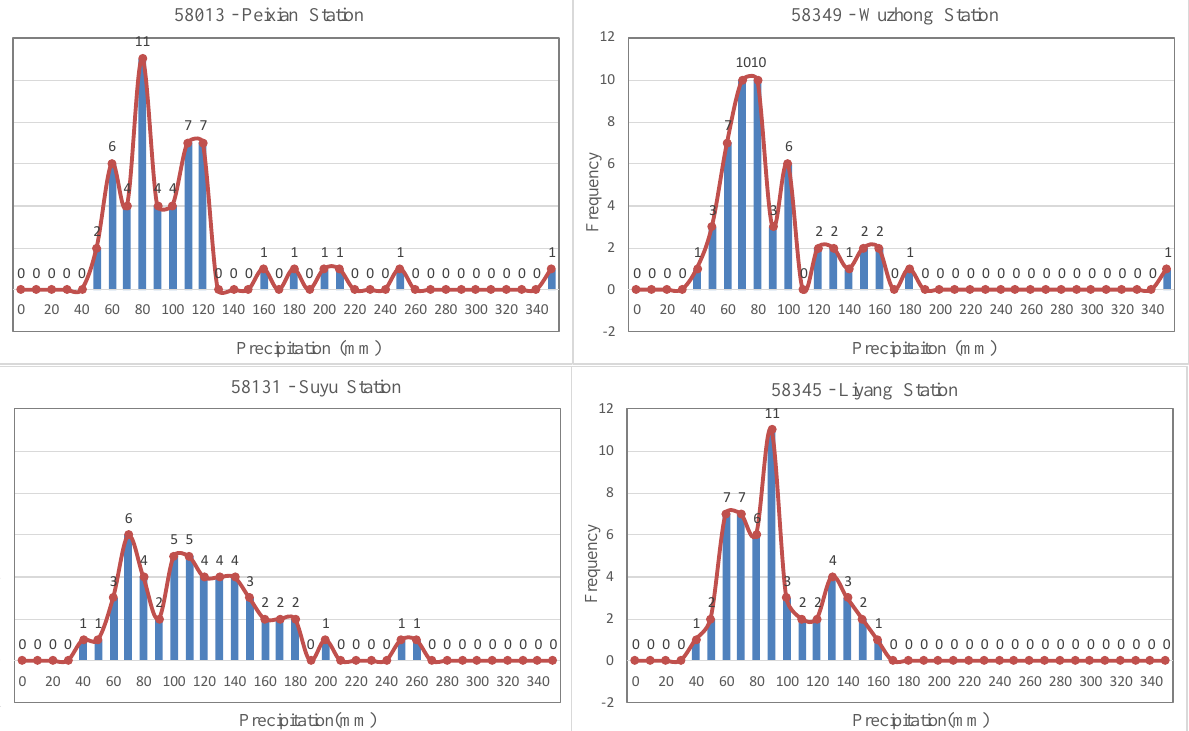
Figure 6. Frequency diagram of AMS data at representative site.